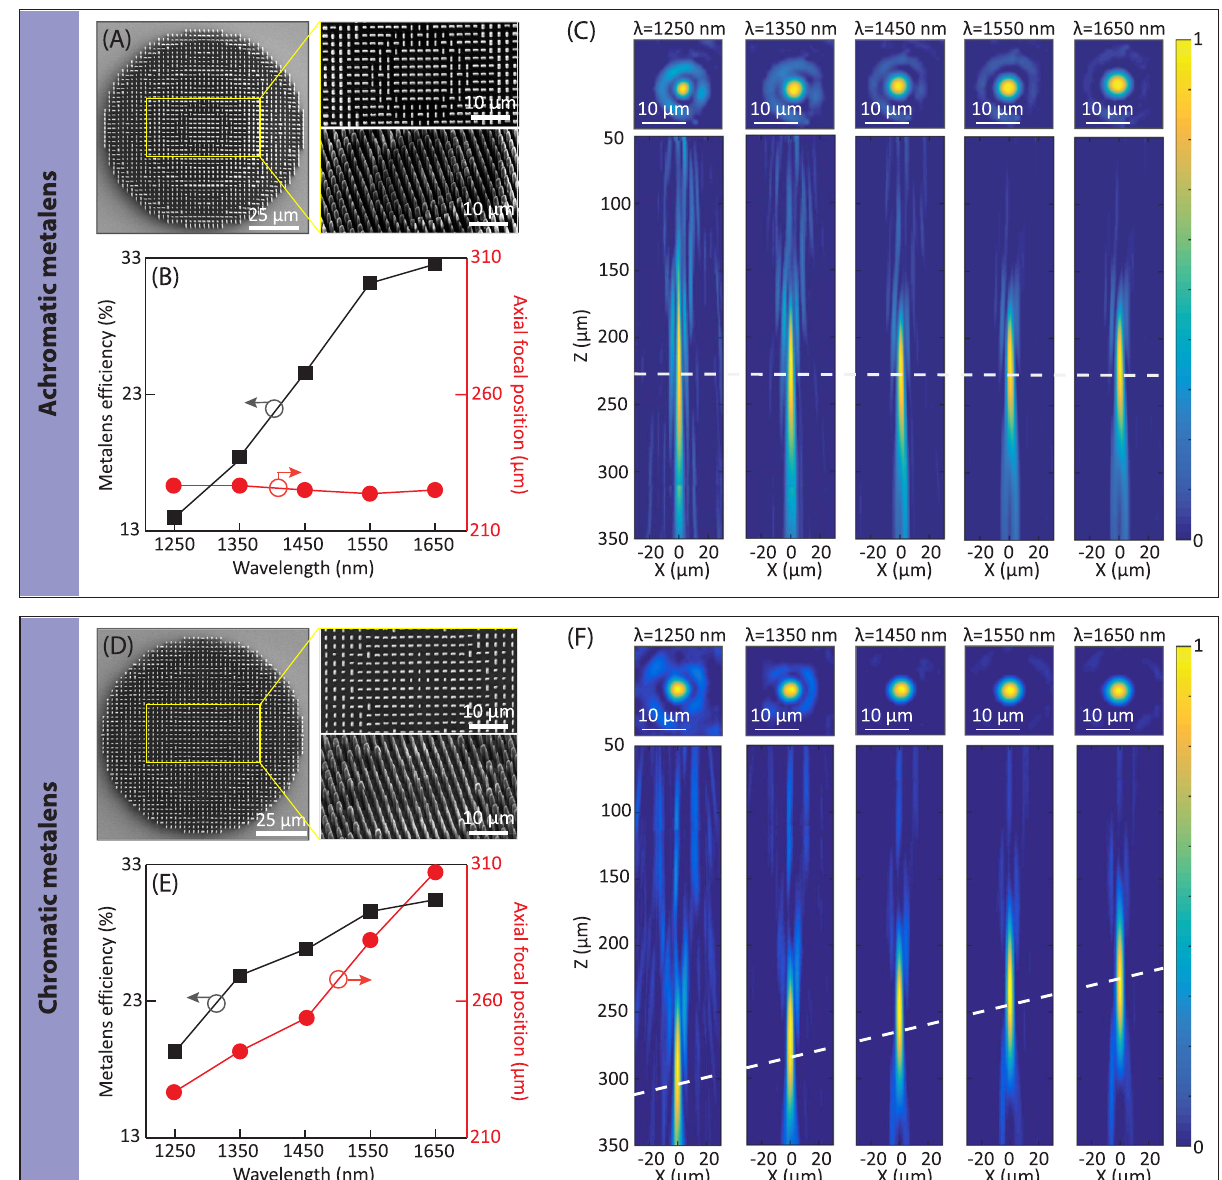
Fig. 3 Experimental characterization and comparison of an achromatic metalens and a chromatic metalens on a glass substrate. A SEM images of the achromatic metalens, with magni fi ed area images in the top (top inset) and the oblique (bottom inset) views. B Experimentally characterized metalens ef fi ciency and axial focal positions of the achromatic metalens on planar substrate at different wavelengths. C Experimentally characterized point-spread functions of the achromatic metalens in both transverse (top) and longitudinal (bottom) planes at fi ve different wavelengths of 1250 nm, 1350 nm, 1450 nm, 1550 nm, and 1650 nm, respectively. D – F The counterparts of ( A – C ) for the case of a chromatic metalens on planar substrate, which has the same spherical lens pro fi le as the achromatic metalens but without the group delay